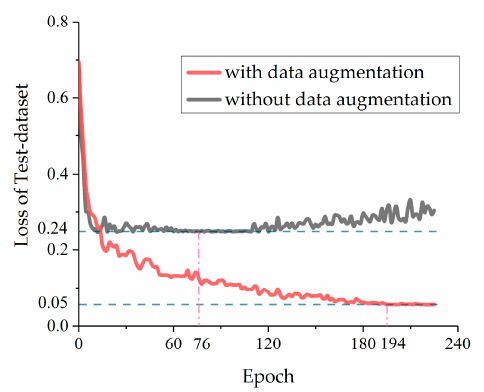
Figure 14. The loss curves for training OSCNet with and without data augmentation.